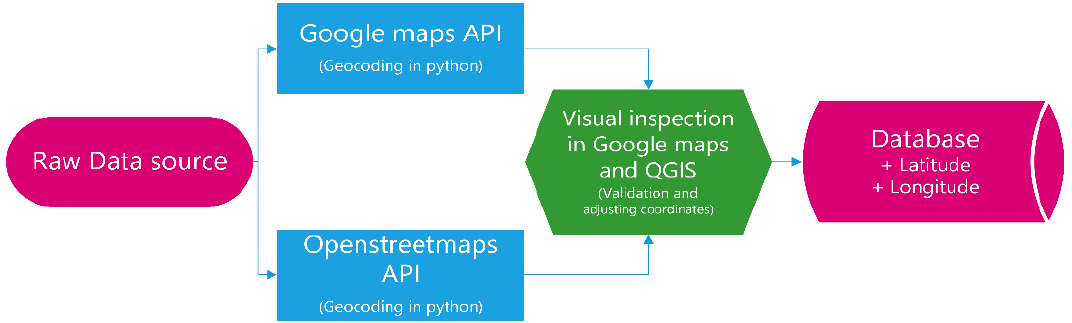
Figure 2. Flowchart for OSM and the Google Maps Python application program interface (API) geocoder.